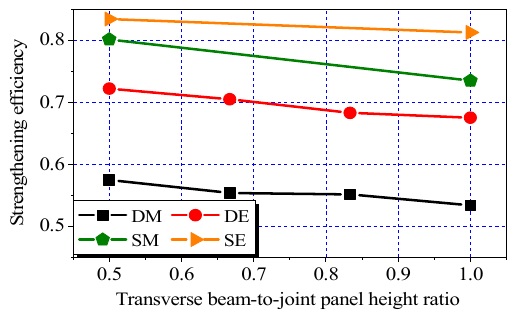
Figure 10. Effect of transverse beam-to-joint panel height ratio.